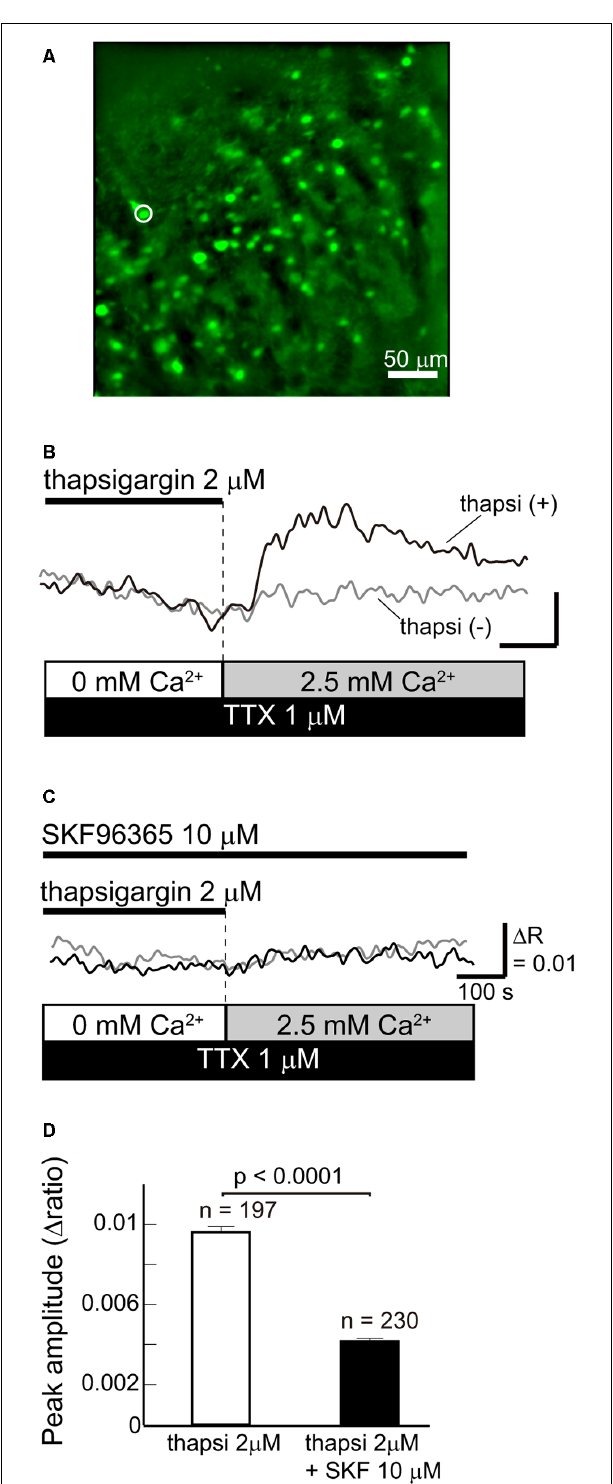
FIGURE 1 | Functional store-operated calcium channels (SOCCs) existed in striatal GABAergic neurons. (A) Fluorescence image of a striatal slice from a GAD67-GFP mouse. Striatal GABAergic neurons were identified by GFP fluorescence (green) and ROIs were placed on the GFP-positive somata